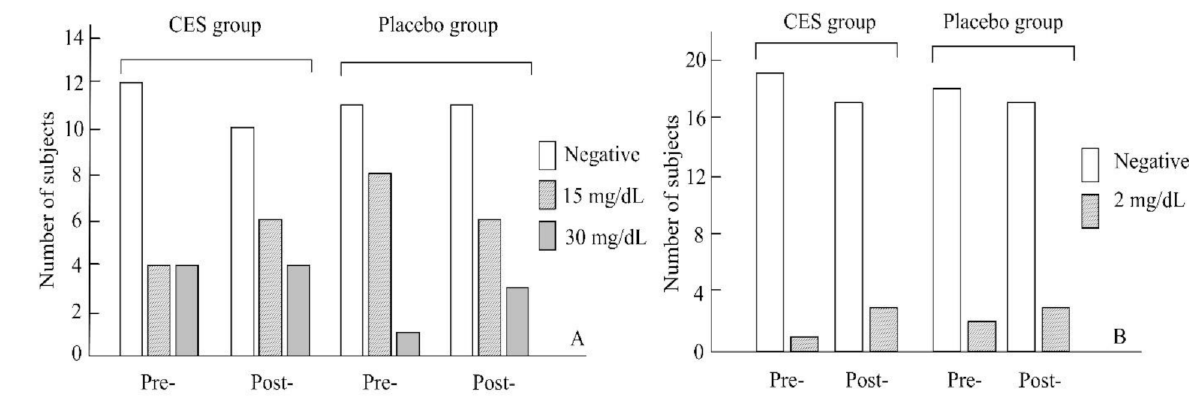
Figure 2. Changes in proteinuria ( A ) and urobilinogen ( B ) in the two groups. Changes in pretrial and posttrial POMS scores were found in the two groups (Table 3). Effects were found in total mood disturbance over time (F = 9.14, η p 2 = 0.31, p = 0.007), between groups (F = 3.56, η p 2 = 0.15, p = 0.07), and for time × group (F = 0.74, η p 2 =